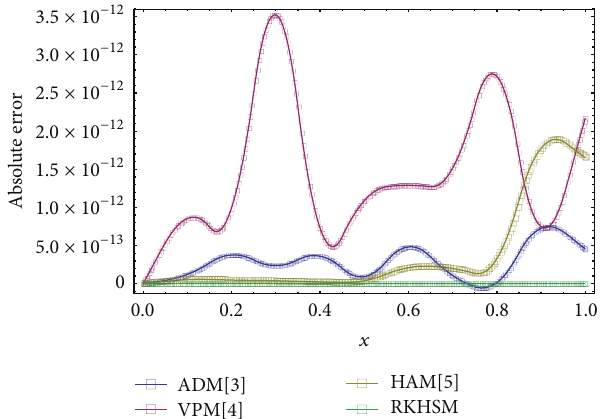
Figure 4: Comparison of absolute error of ADM, VPM, HAM, and RKHSM for Example 11.